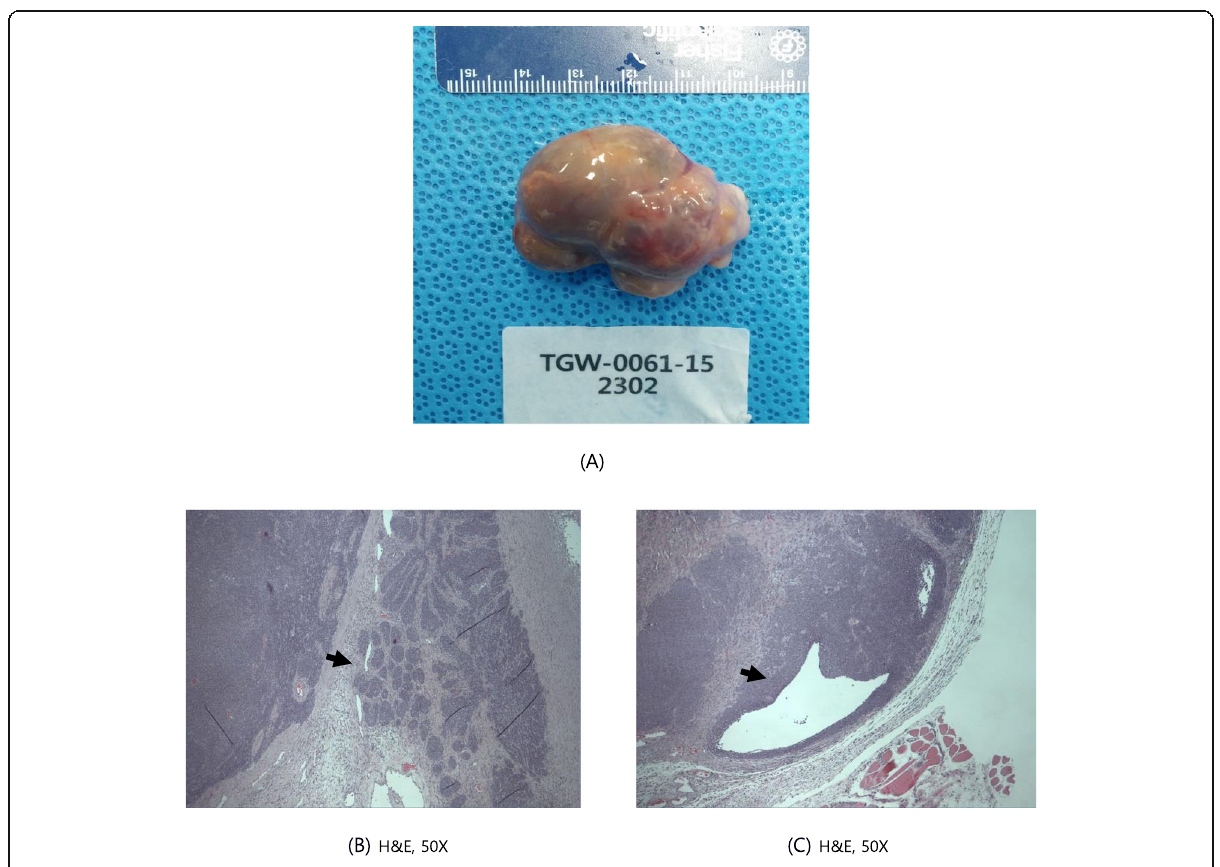
Fig. 6 Cysts and mass in the submandibular region of female G3 (middle dose group; rat number 2302) ( a ) Necropsy finding ( b ) Basal cell